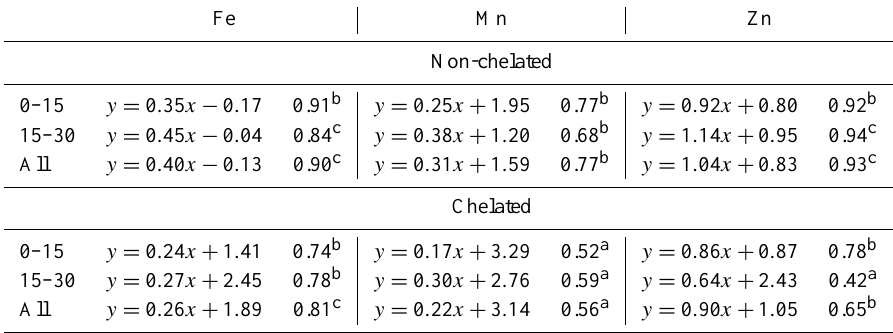
Table 5. Changes in available copper with respect to other micronutrient elements (Fe, Mn, and Zn) in the non-chelated and chelated systems of the studied semiarid alkaline soils of the Southern High Plains, USA ( n = 9).